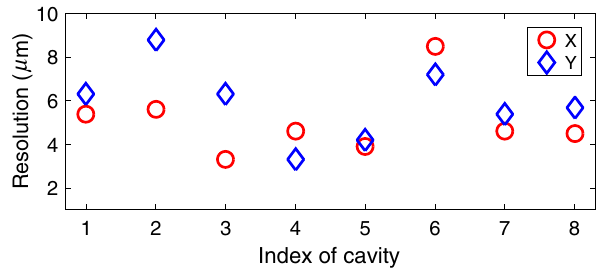
FIG. 17. Resolutions for the HOMBPMs in the horizontal and vertical